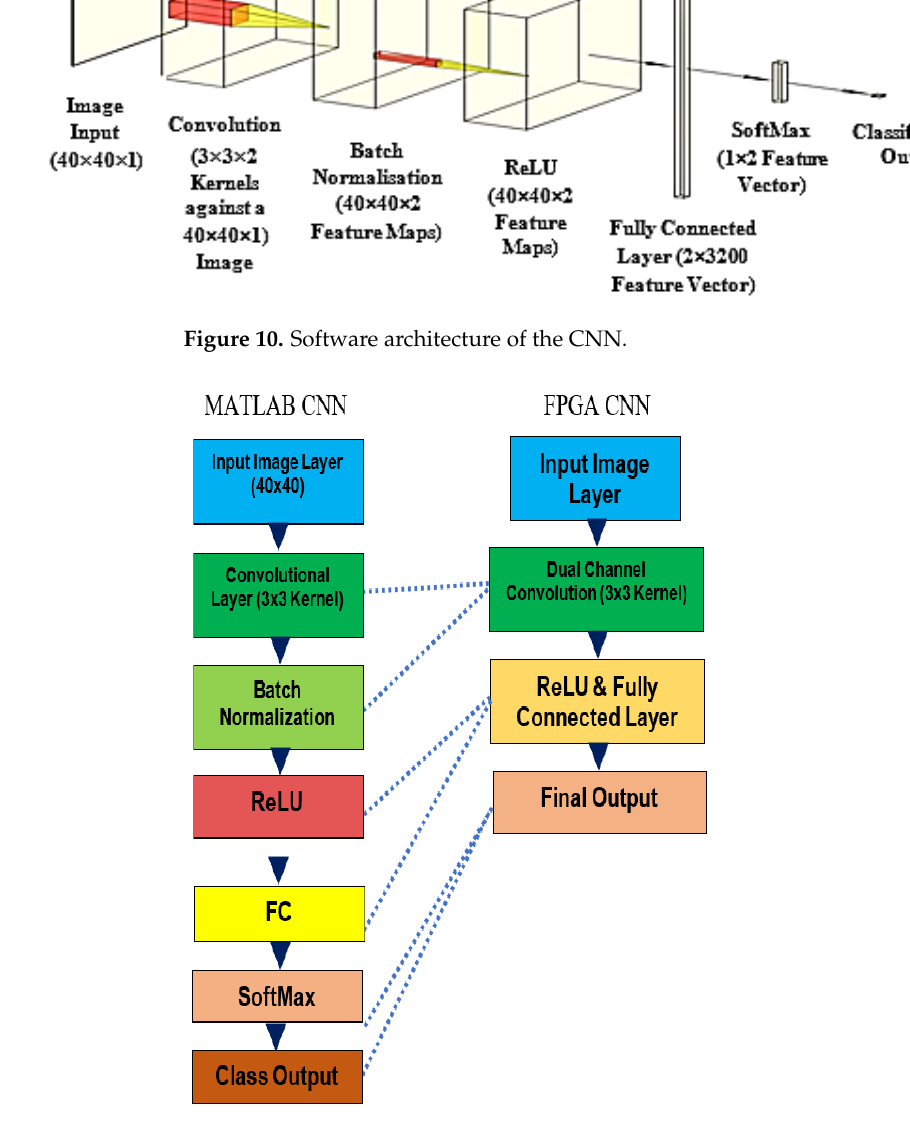
Figure 11. Customized CNN hardware implementation.